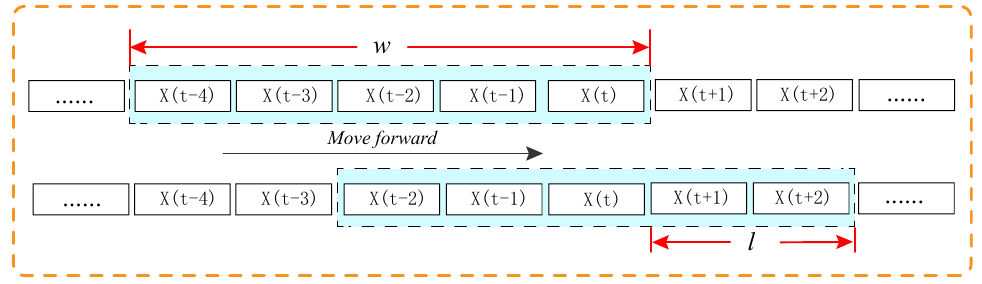
Figure 1. The schematic of a sliding window.